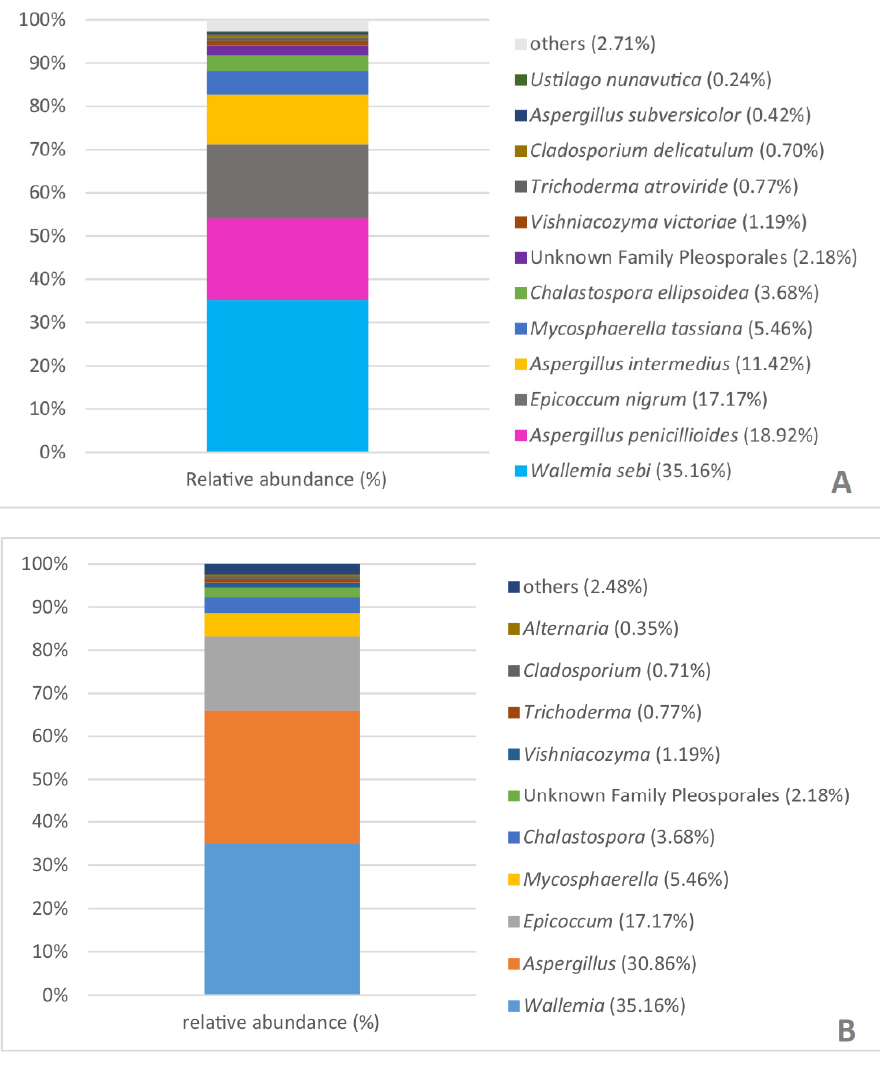
Figure 3. Relative abundance (%) of fungal species, the share of which in the total number of reads exceeded 0.2% ( A ) and 10 most abundant fungal genera in the examined sample ( B ). Table 2. Concentration of fungal aerosol (CFU/m 3 ) in the examined horse stables and outdoors. The presented values are means of three replicates. Values in brackets show standard deviation. The highest values within each fraction of bioaerosol are shown in